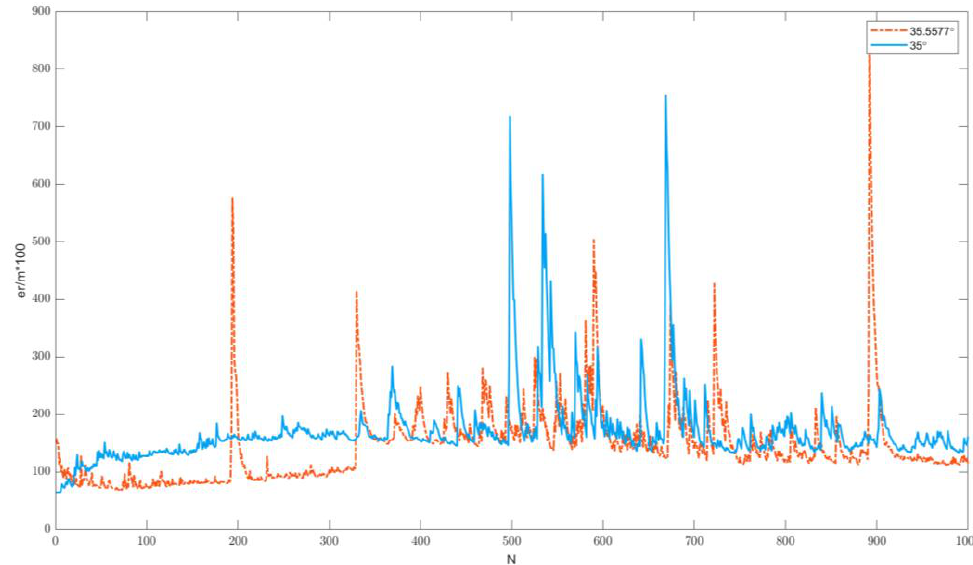
Figure 7. Comparison of errors for two particular pitch angle values.